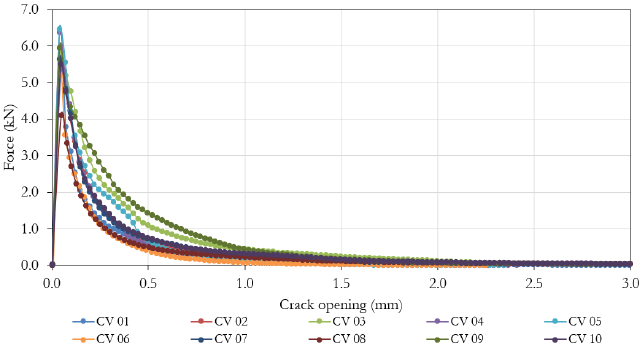
Figure 7. Force versus crack width curves for conventional concrete.